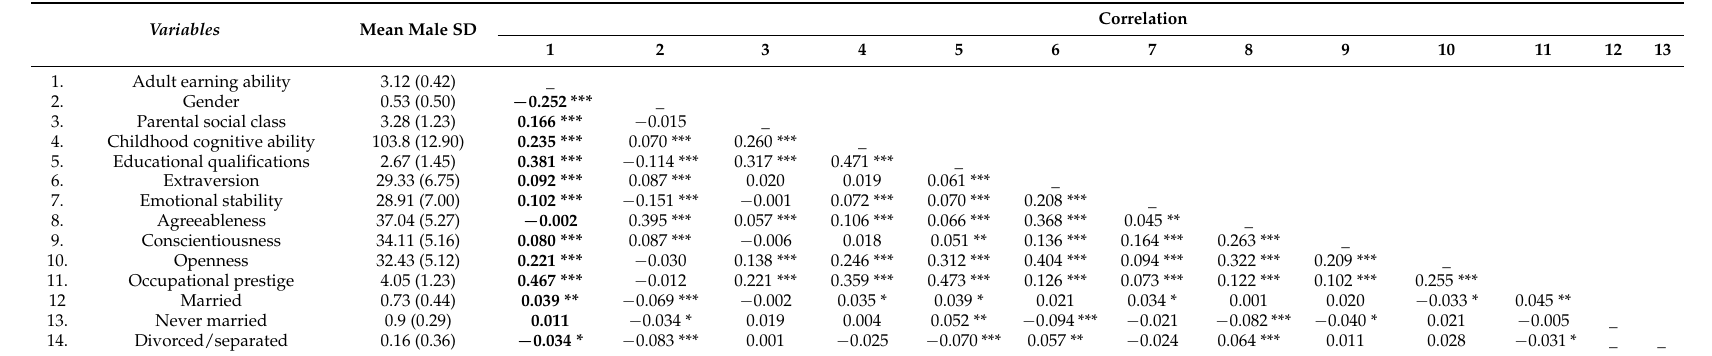
Table 1. Pearson correlations matrix for the variables examined in the